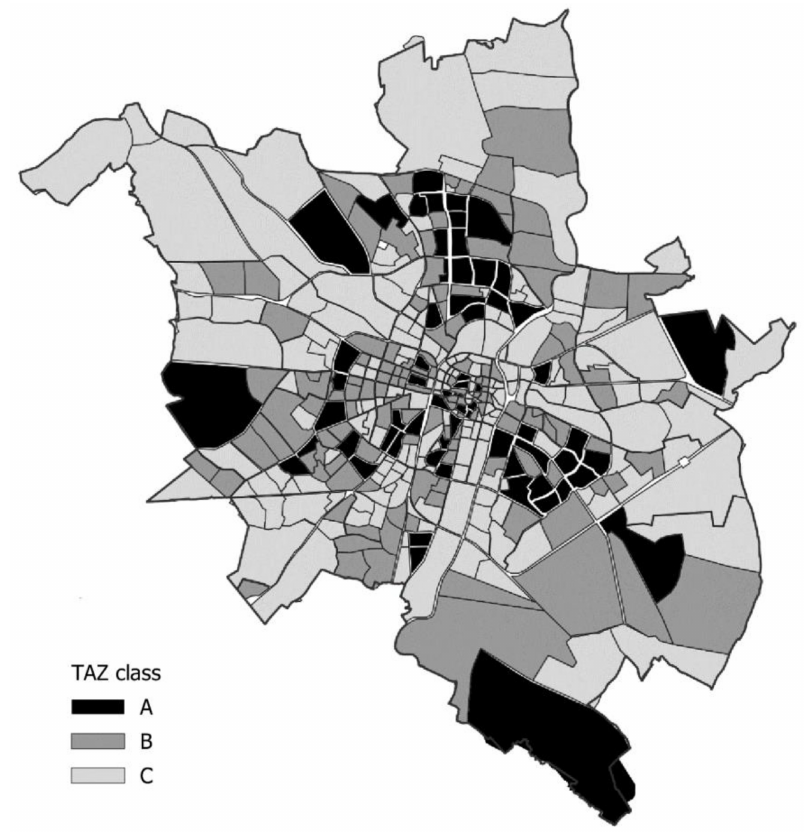
Figure 2. Classification of TAZs in